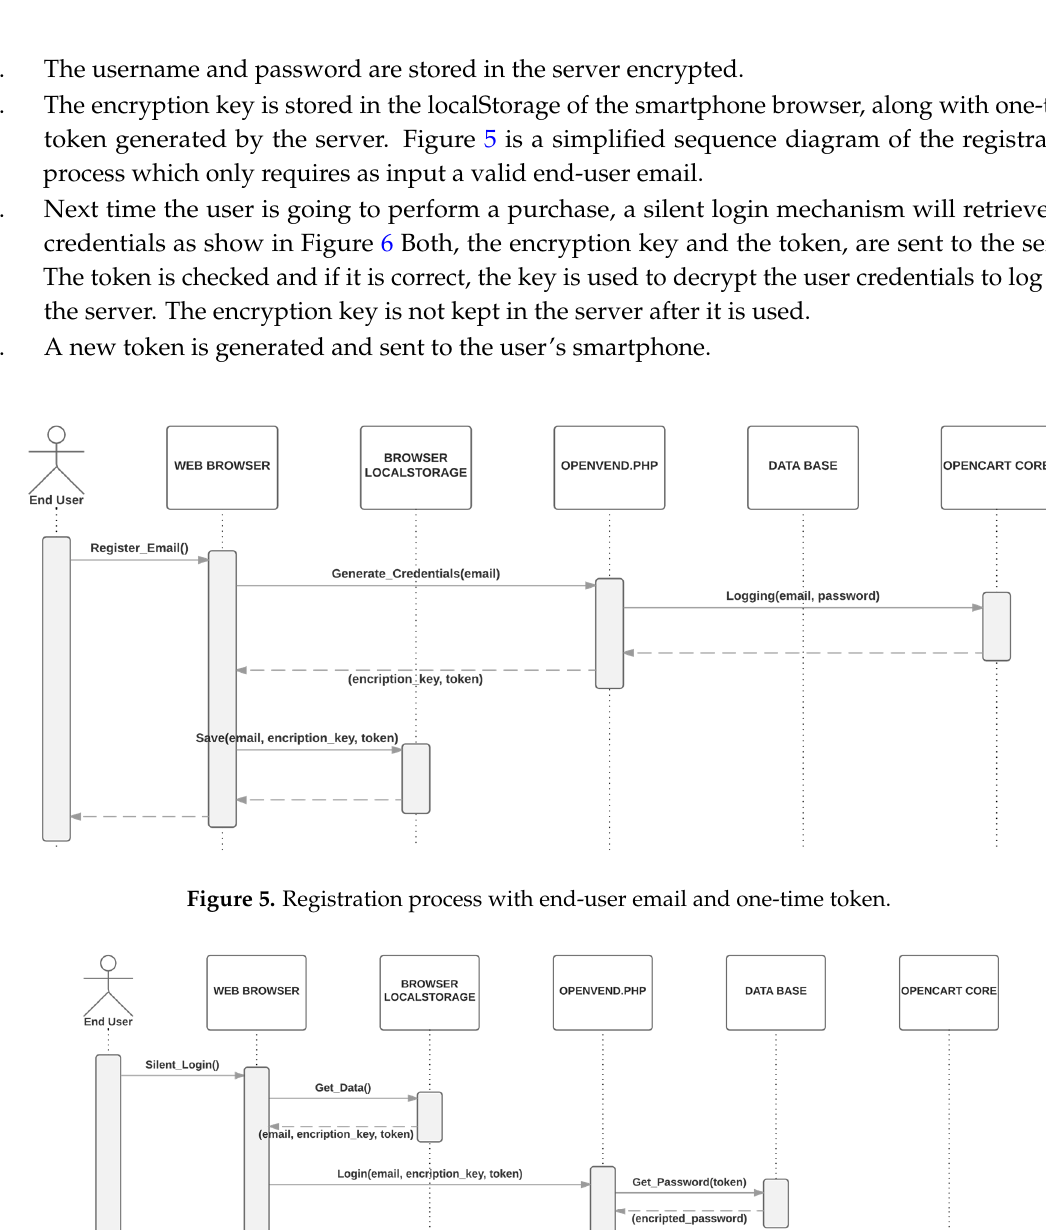
Figure 6. Silent logging process and credentials tokenization.